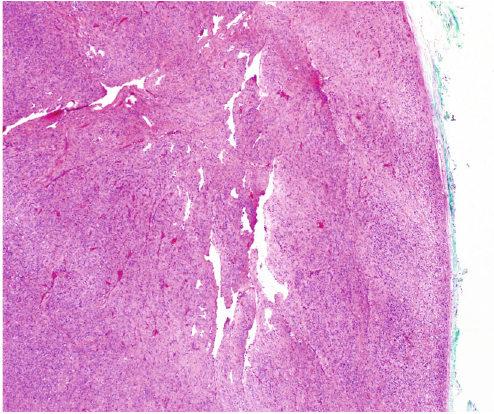
Figure 4: Delicate thin-walled vascular spaces, with hemangiopericytoma-like vasculature, were observed at the periphery (H&E, ×